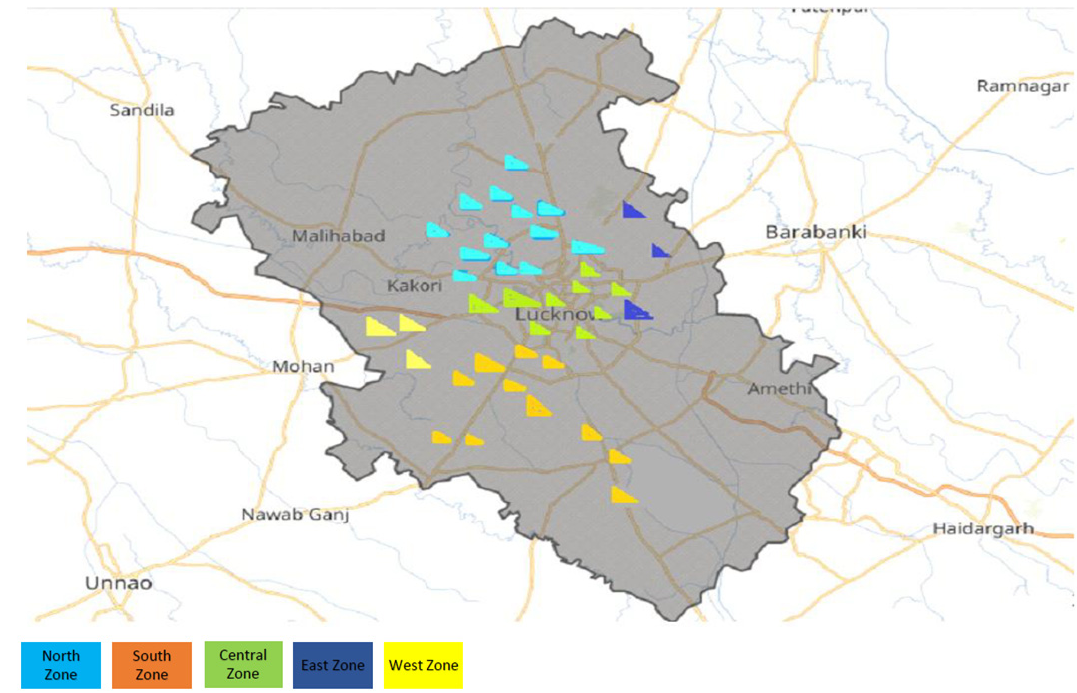
Figure 3. Map depicting zonal distribution of schools screened in the study.